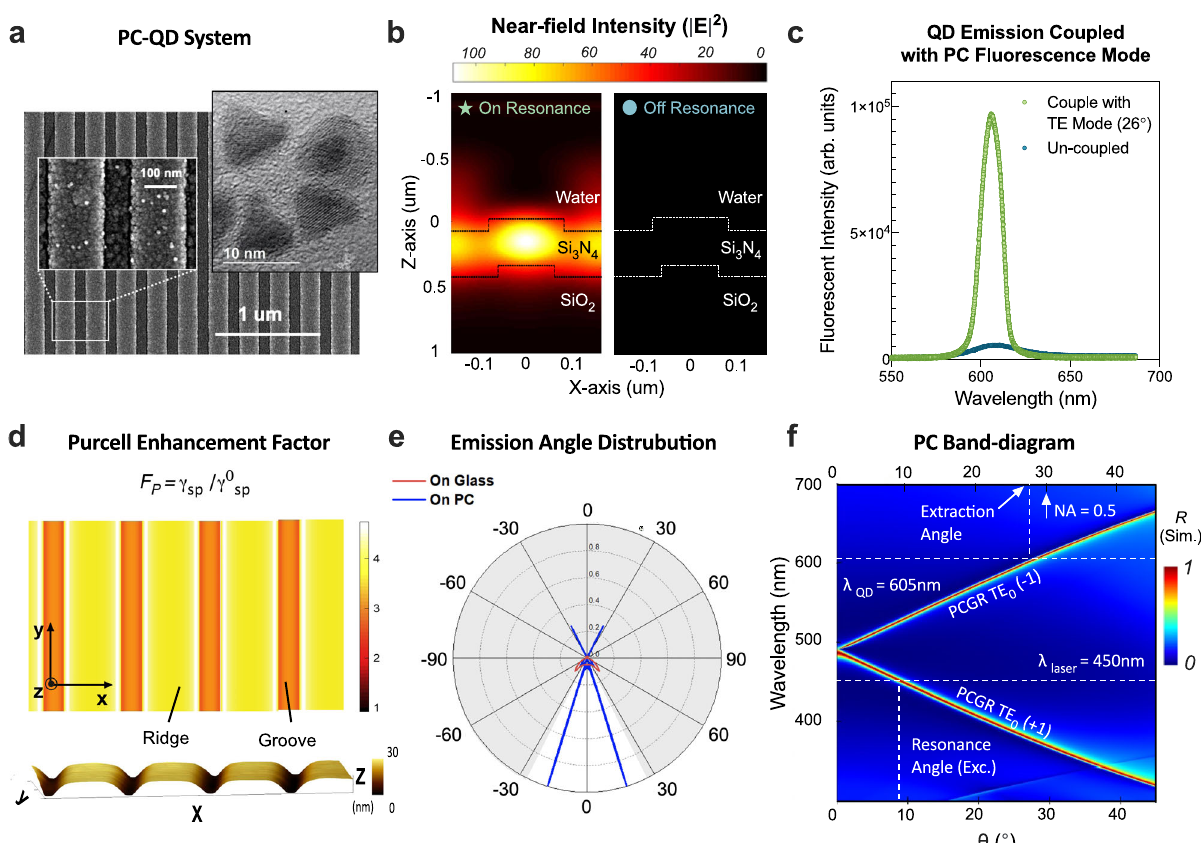
Fig. 2 | PC-QD system and simulation-based analysis for each enhancement effect. a SEM image of the PC-QD coupled system at 40k magni fi cation. Scale bar, 1 µ m. The left inset shows an enlarged area for detail at 130k magni fi cation with a scale bar of 100nm. The right inset shows a TEM image of the QD-605 at 600k magni fi cation. Scale bar, 10nm. More than three experiments were repeated independently with similar results. b FDTD simulation of near- fi eld intensity dis- tribution of the PC cross-section, both on-resonance ( θ =9.2°, left) and off- resonance ( θ =20°, right). c Angle-resolved emission spectrum measurements for QD-605whencoupledwiththeenhanced fl uorescentmode(green)andsolitaryon